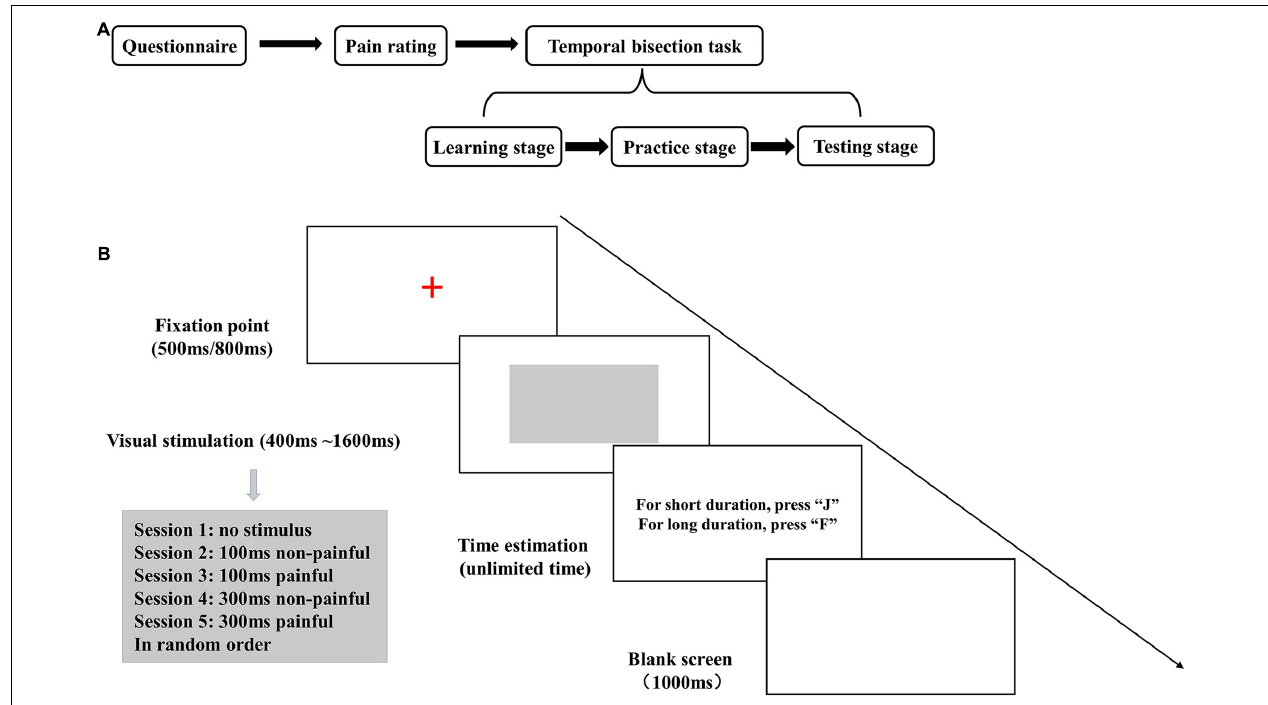
FIGURE 1 | (A) Diagram of the study flow. (B) The experimental stage of the temporal bisection task. The gray rectangle was presented for 400, 600, 800, 1,000, 1,200, 1,400, or 1,600 ms. Electrical stimulation was applied during the last 100 or 300 ms of the visual stimulus